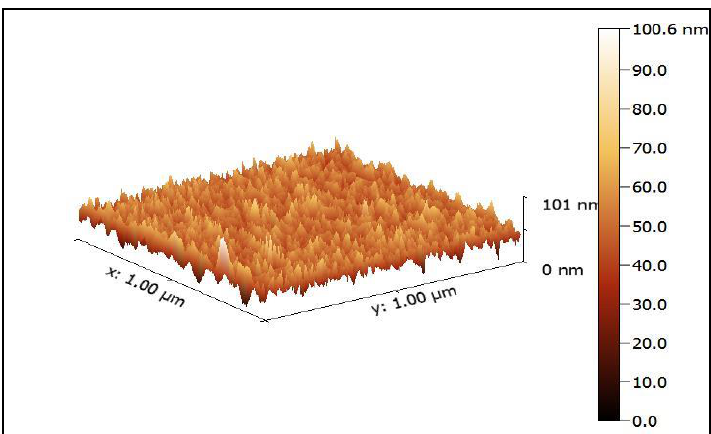
Fig. 4 . Atomic force microscopy (AFM) of graphite expressed as three-dimensional topgraphy.